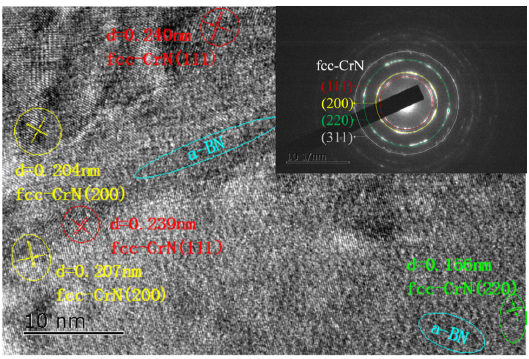
Figure 3. HRTEM micrograph and SAED pattern of Cr 43.9 Ti 2.4 B 4.0 N 49.7 film.